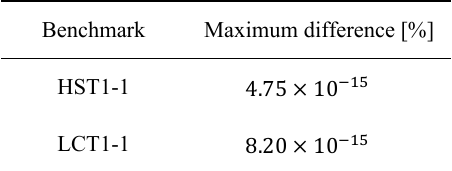
Table 5. The maximum difference in standard deviations due